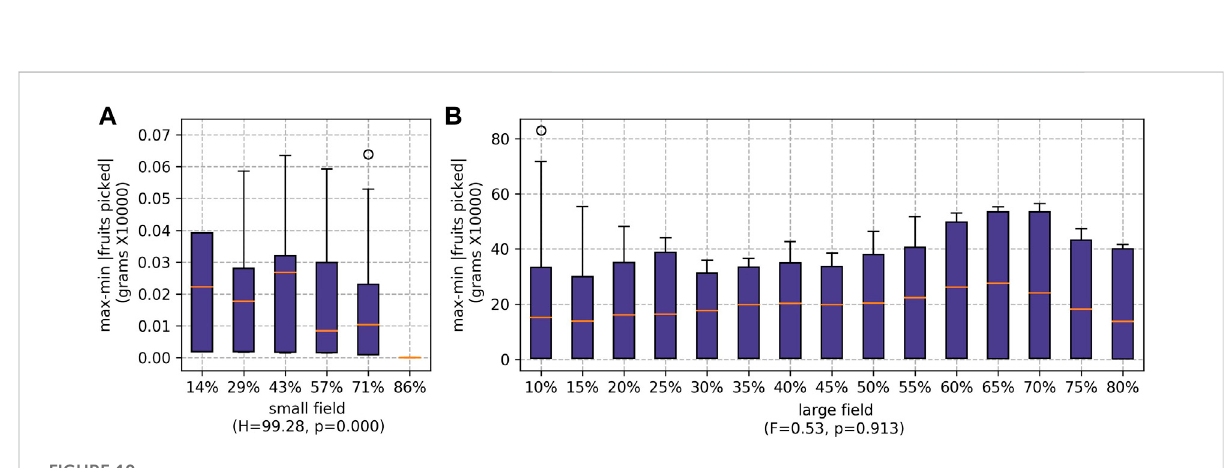
FIGURE 10 Results for max-min |fruits picked| for different percentages of agents being employed as runners for both farms: (A) the small fi eld and (B) the large fi